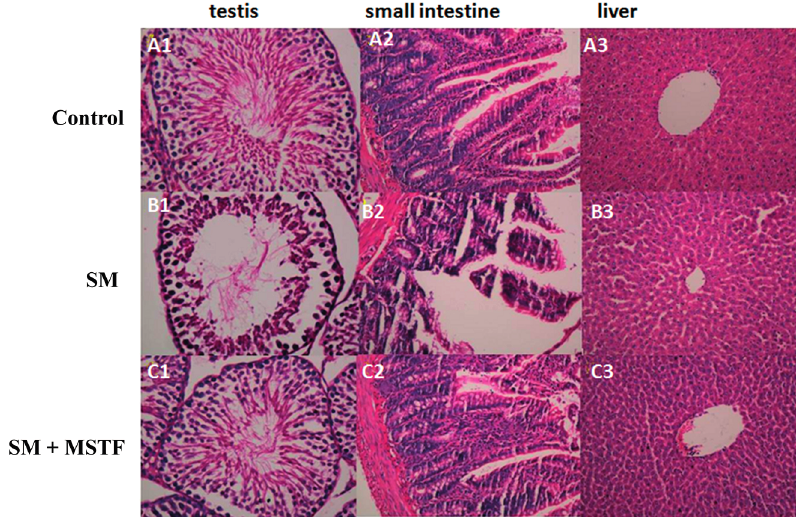
Figure 2. Representative photographs showing the histopathologic changes in testis, small intestine and liver tissues on the third day post-exposure ( n = 5